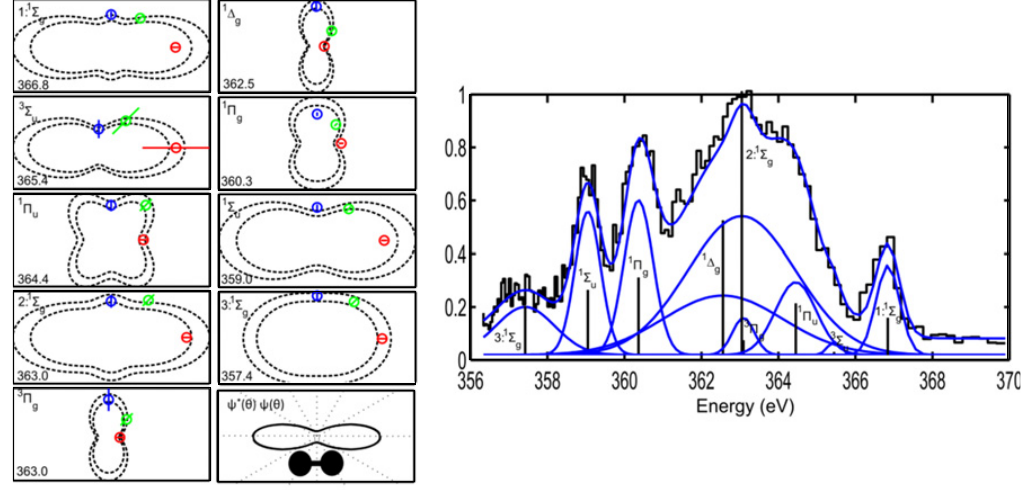
Figure 5. Left: The Auger angular distribution in N 2 , from LCLS measurements [9]. The dashed curve (black) shows the calculation convolved with the measured molecular ensemble distribution. Each panel is labelled by the central energy of the Auger feature (bottom-left corner) and the assigned final state (upper-left corner), in units of eV. The states are labeled as follows: (1) (3 (cid:2) g ) − 2 X -state, (2) (1 (cid:6) u ) − 2 , (3) (2 (cid:2) u ) − 2 . Right: N 2 Auger spectrum for unaligned ensemble of molecules. The curves below the composite spectrum indicate each feature’s contribution to the total spectrum and are labeled next to the peak. The states in the spectrum on the right are labeled as follows: (1) (3 (cid:2) g ) − 2 X -state, (2) (1 (cid:6) u ) − 2 , (3) (2 (cid:2) u ) − 2